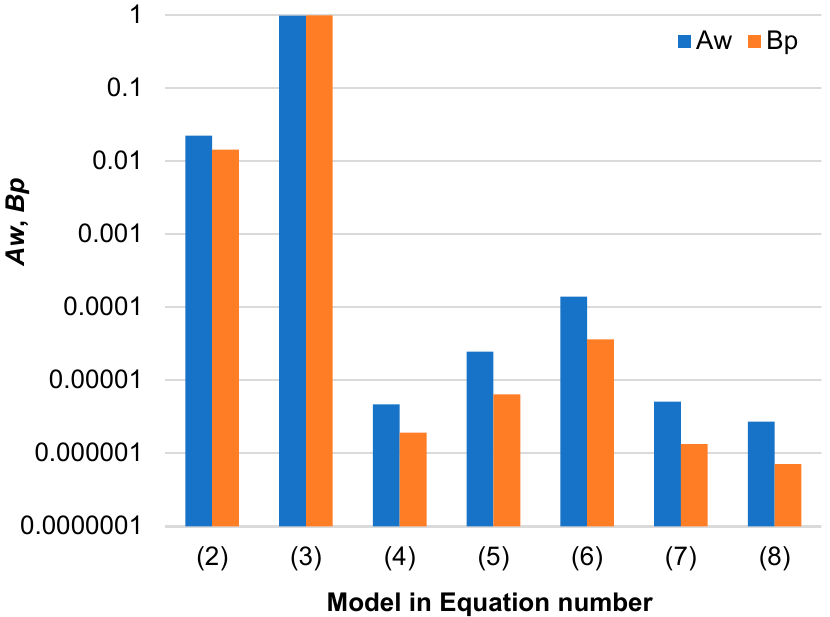
Figure 3. Model selection results from information criteria for n = 3. Akaike weights Aw from the Akaike information criterion (blue), and posterior model probabilities Bp from the Bayesian information criterion (orange).